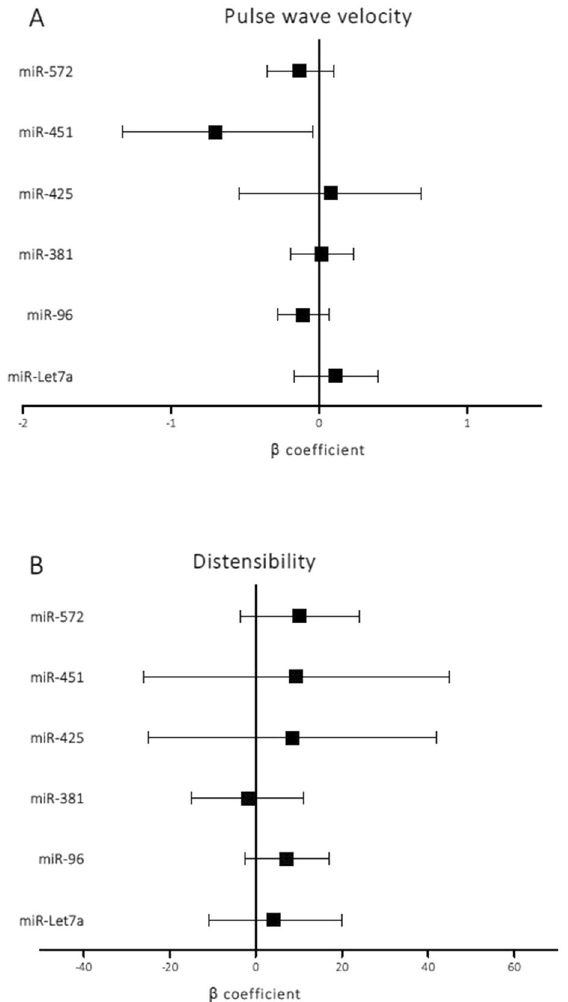
Figure 3. Adjusted β linear regression estimates with 95% confidence intervals of the effect on PWV and distensibility of a ΔCt increase (decreased expression) of the different miRs applied to overall population. The models were adjusted for RA disease onset, body mass index, age, ischaemic heart disease, ictus, hypertension, dyslipidaemia, type 2 diabetes mellitus, disease-modifying antirheumatic drugs, biological agents, corticosteroids, and non-steroidal anti-inflammatory